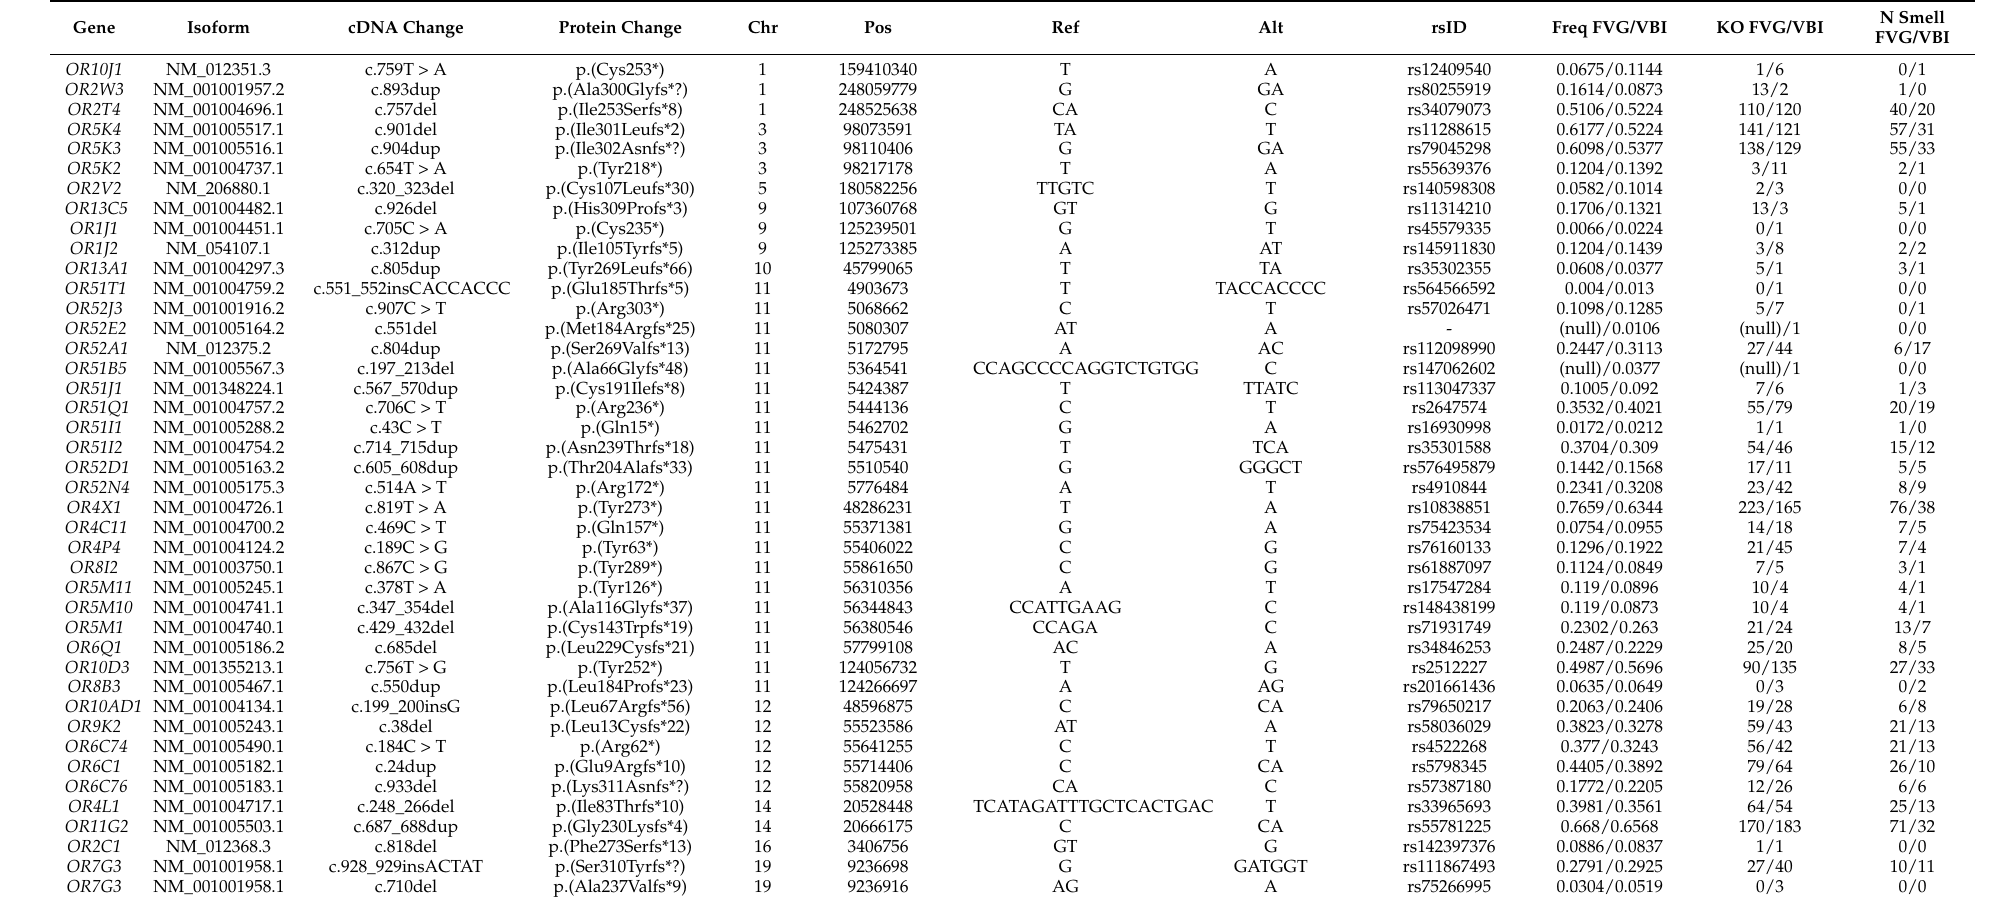
Table 1. Characteristics of the homozygous LoF variants in OR genes identified in our Italian cohorts. All data are aligned to the human genome reference build 37 (GRCh37), and VEP (Variant Effect Predictor, https://www.ensembl.org/info/docs/tools/vep/index.html) version 90 was used to determine the variant consequence. Chr = chromosome, Pos = position, Ref = reference allele, Alt = alternative allele, Freq = frequency of the reference allele, KO = knockout, N = number, FVG = Friuli-Venezia Giulia, VBI = Val Borbera. The last two columns refer to the number of KO individuals in FVG and VBI (“ KO FVG/VBI ”) and the number of human knockout (HKO) with information of Sniffin’ Sticks test and used in regression tree analysis (“ N smell FVG/VBI